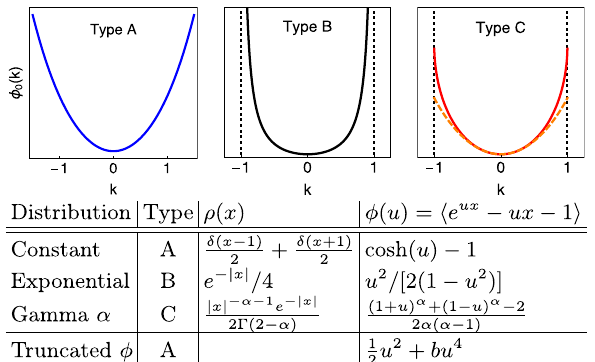
Figure 1. We classify amplitude distributions ρ into three types according to their moment generator φ . Type A: φ is unbounded without singularities. Type B: φ diverges upon approaching two singularities, taken as lying at ± 1 . Type C: φ is bounded with singularities at ± 1 in higher derivatives. Examples for each type are given, d x x 2 ρ( x ) = 1 . For the Gamma distribution we assume 0 < α < 2 and show the cases α = 0.6 normalized as (solid line) and α = 1.6 (cid:31)